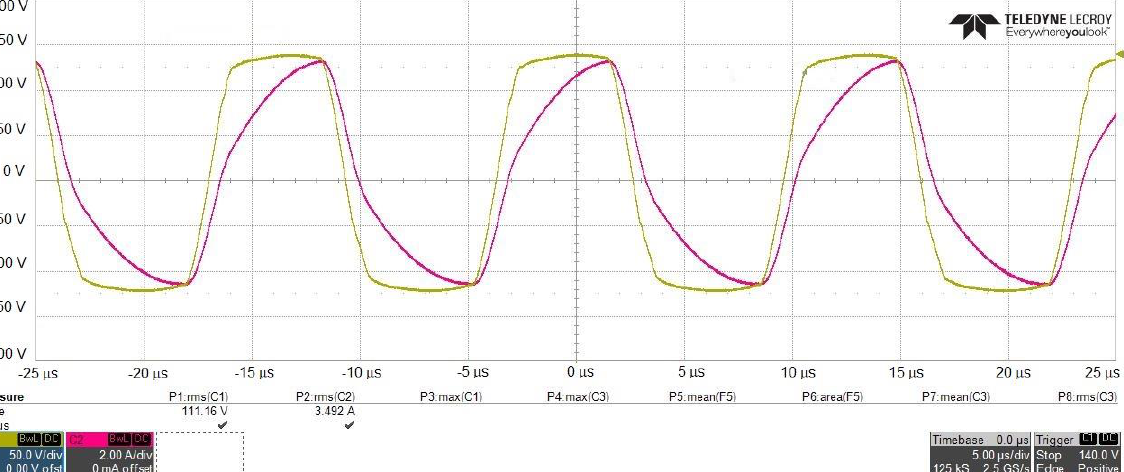
Figure 28. Receiver coil voltage (C1, green) and current (C2, purple) at 75 kHz.